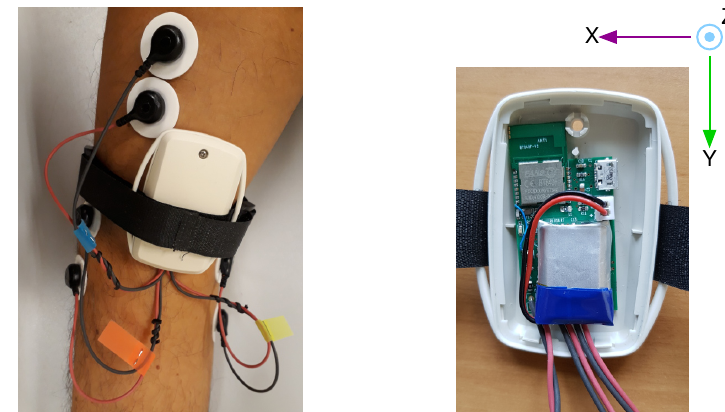
Figure 15. Positioning of the electrodes and device on the upper portion of the right arm. The electrodes identified by the yellow tab contact the biceps brachii, those identified with the orange tab the triceps brachii, and those with the blue tab the deltoideus medium. The orientation of the mechanical axes is visible in the right picture, showing the interior of the case with the battery on top of the circuit board. Once worn, axes are oriented so that the Y direction is along the arm, pointing downwards at rest, X points towards the front, parallel to the sagittal plane, and Z points towards the arm, along the coronal plane.